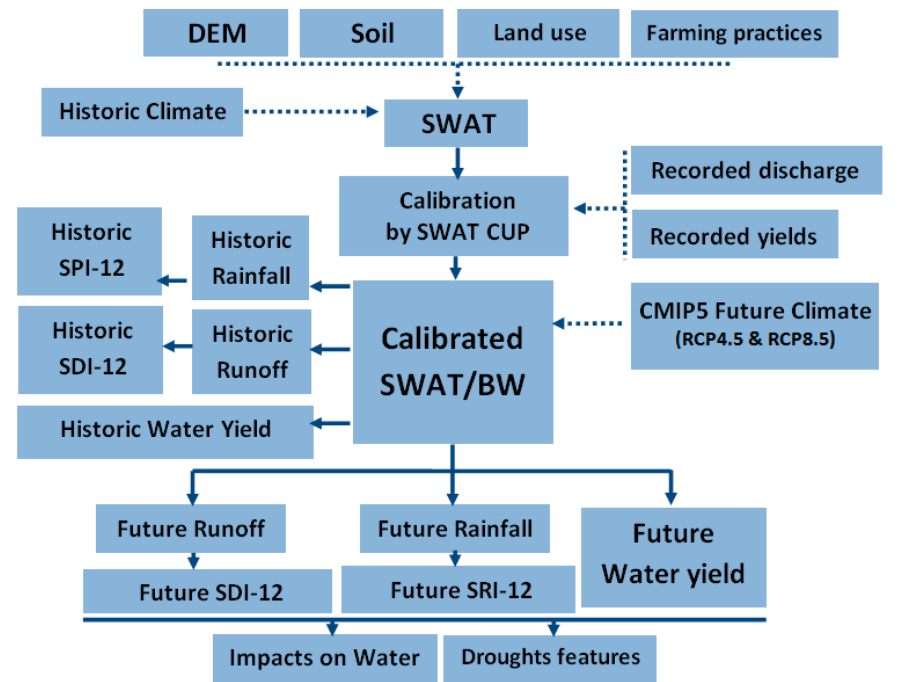
Figure 3. Research methodology flowchart.